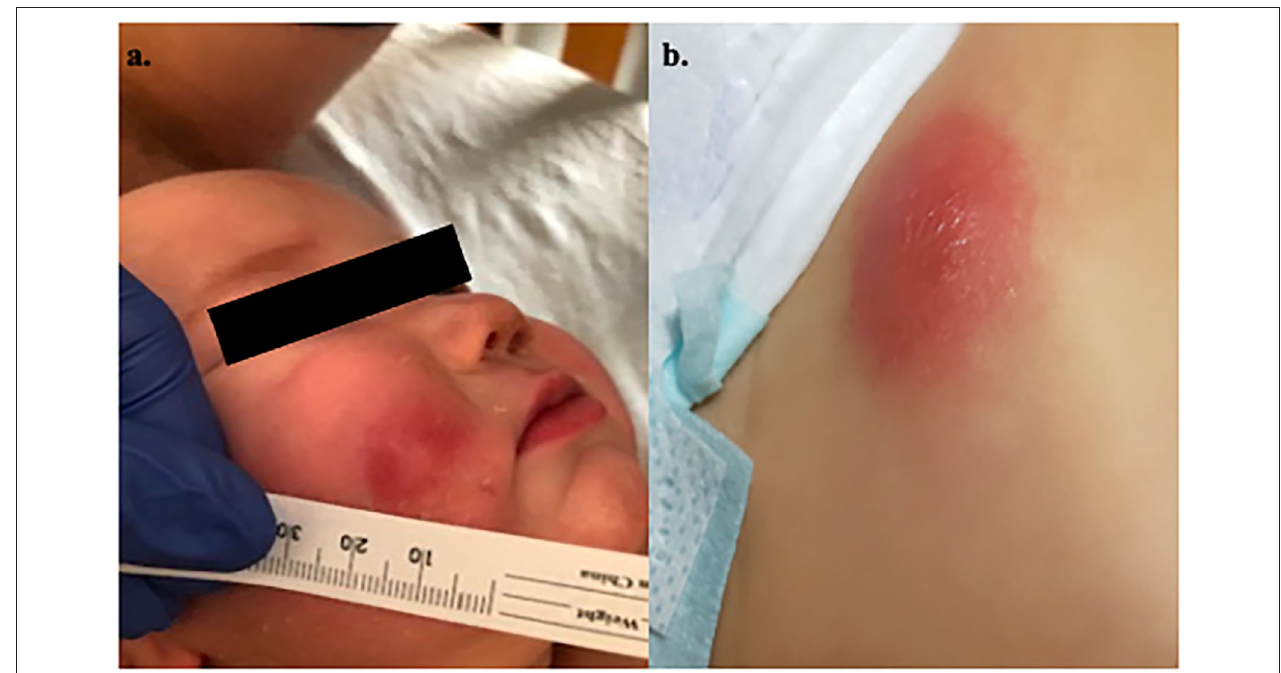
FIGURE 1 | Patient 1’s rash. (a) Rash on right cheek. (b) Rash on lower